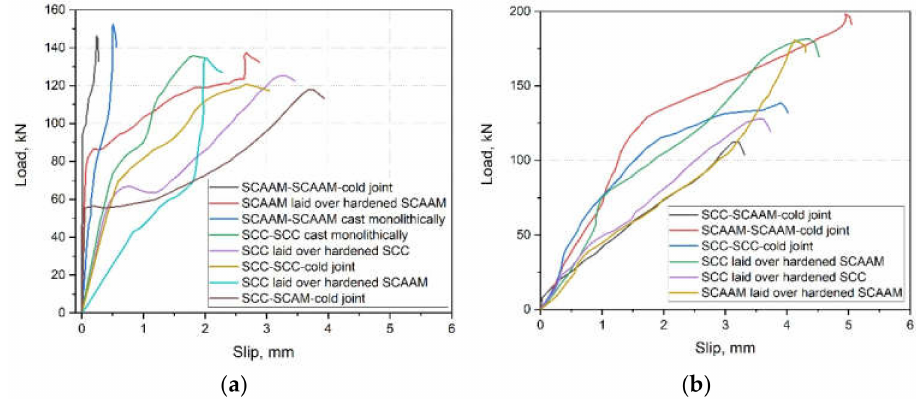
Figure 8. Correlation of load and slip in conventional ( a ) and modified ( b ) push-off test